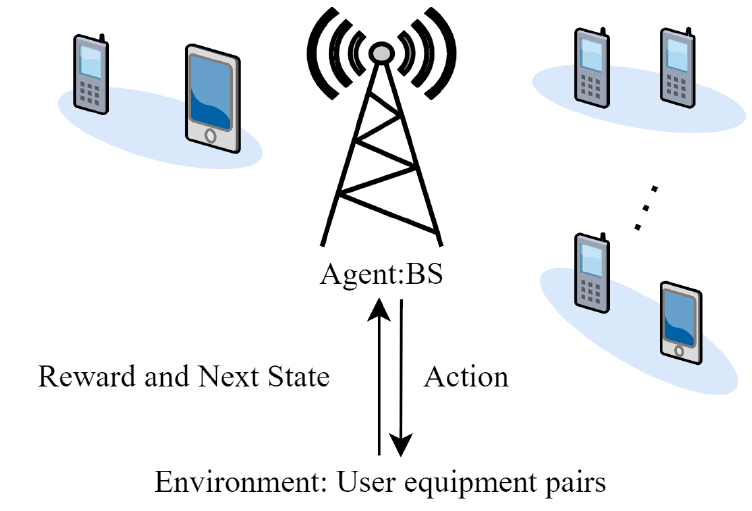
Figure 5. DRL scenario.